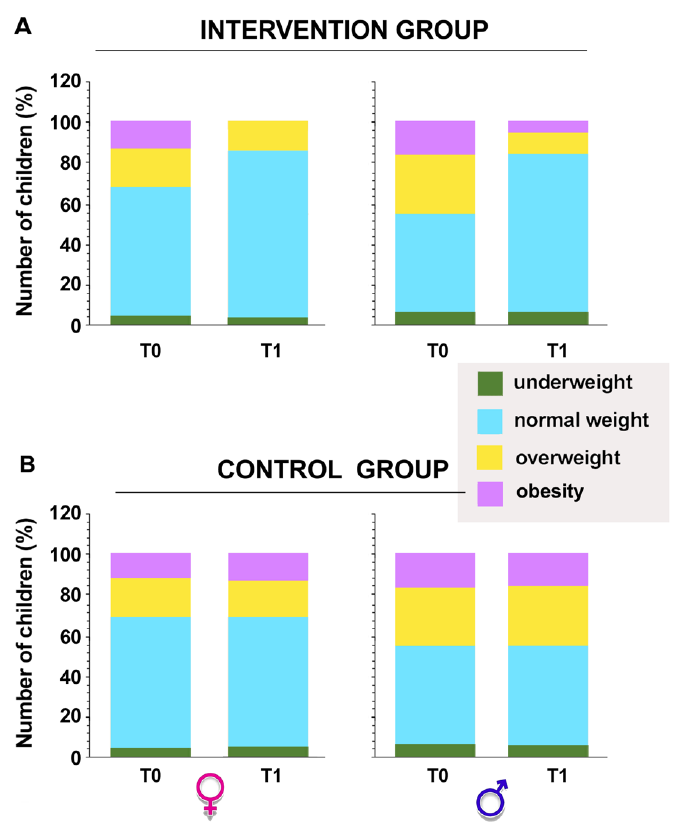
Figure 3. Percentage of overweight, underweight, or normal weight children or children with obe- sity in the intervention ( A ) and control ( B ) groups obtained pre (T0) and post (T1) intervention. The sample was also divided between girls and boys. Intervention group p = 0.0001 by Fisher ’ s exact